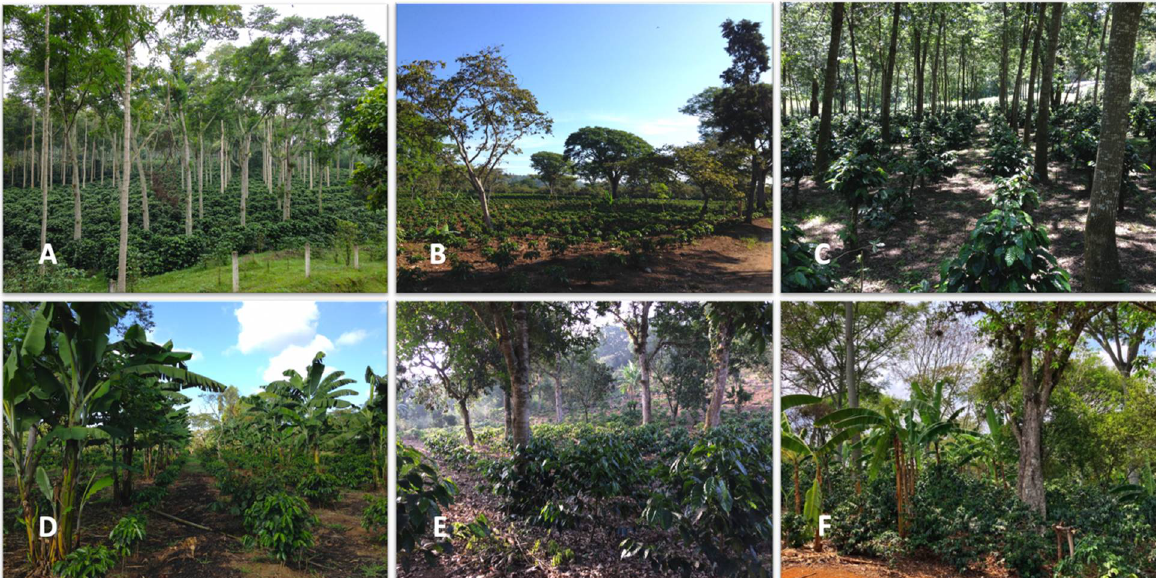
Figure 1. Examples of coffee farming in agroforestry systems. ( A ) AFS set up with a single shade tree species (Veracruz, Mexico). ( B ) AFS with a low level of shade and a mixture of tree species (Veracruz, Mexico). ( C ) AFS with a high level of shade set up with a single shade tree species (Matagalpa, Nicaragua). ( D ) AFS set up with banana and citrus fruit trees (Veracruz, Mexico). ( E ) AFS set up in heterogeneous forest undergrowth with a low level of shade (Veracruz, Mexico). ( F ) AFS set up in heterogeneous forest undergrowth with a high level of shade (Veracruz, Mexico). Photos © Jean-Christophe